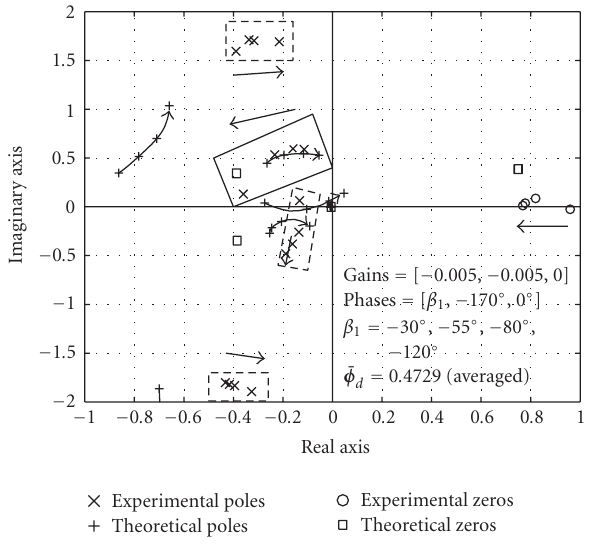
Figure 11: Closed-loop root locus for harmonic 1 with varying gain.